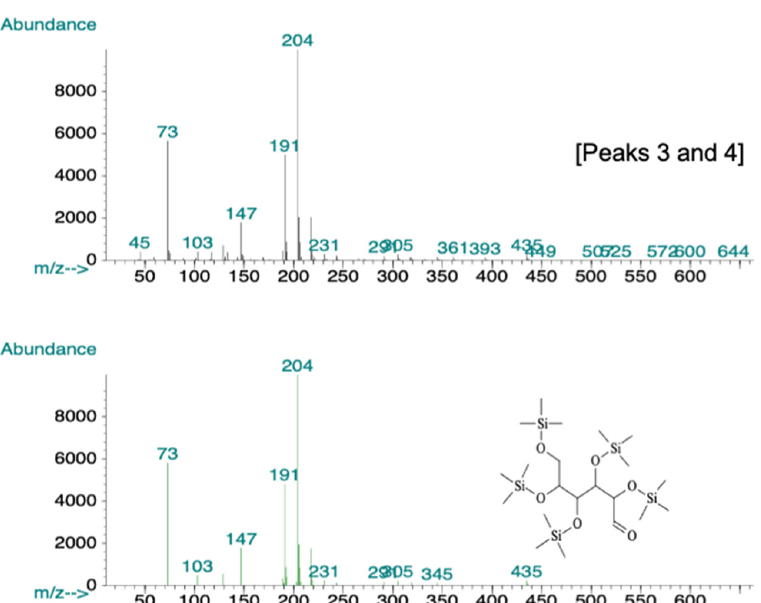
Figure 7. GC-MS spectrum of peak 3 and 4 selected from GC-MS chromatogram and compared with the library of mass spectra stored in the Chemstation database of MS. Comparison showed that both peaks were 95% similar to D -glucose.